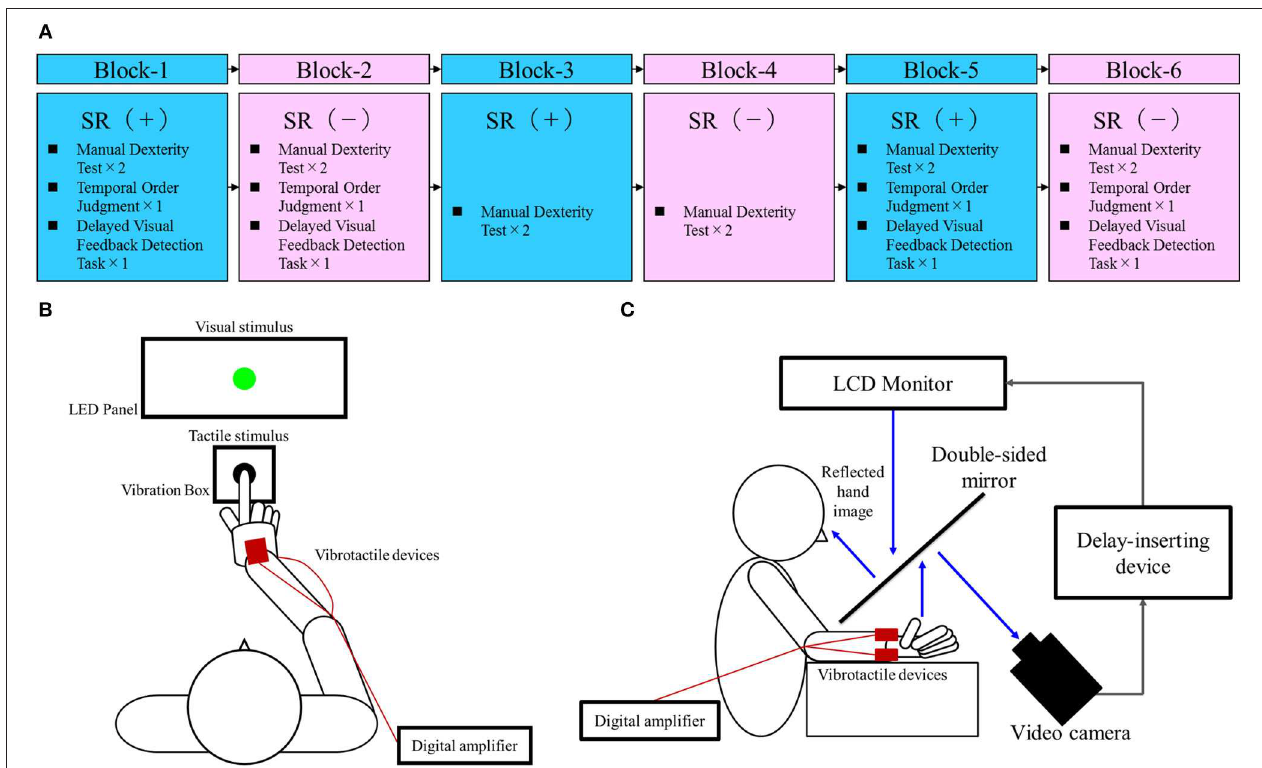
FIGURE 1 | Block design of the experimental protocol and experimental tasks. (A) Block design of the experimental protocol. Blue squares, stochastic resonance (SR) on-condition ( + ); Pink squares, SR off-condition (–). (B) Temporal order judgment task. A visuo-tactile temporal order judgment (TOJ) device (Keio method, UT-0021, Medical Try System, Tokyo, Japan) was used for the present task. This device included an LED panel (UT-0021-2, Medical Try System, Tokyo, Japan) and vibration box (UT-0021-1, Medical Try System, Tokyo, Japan), which provided the visual and tactile stimuli, respectively. The child put the index finger of his right hand in the hole of the vibration box and contacted the vibrotactile stimulator. Therefore, the case could not observe the tactile stimulus. The child was requested to watch the LED panel. The TOJ task device was to set conditions for the synchronized presentation of the visual and tactile stimuli, and the presentation of the visual stimulus at 50 and 100ms earlier than the tactile stimulus (or vice versa). In addition, the setup included a blackout curtain so that the child would not be able to see outside the experimental chamber. (C) Delayed visual feedback detection task. The child’s right hand was placed under a two-way mirror so that he was unable to see his right hand directly. The image of the hand, which was reflected in the two-sided mirror, was filmed with a video camera (FDR-AXP35, Sony, Tokyo, Japan). The movie of the photographed hand was further reflected from an installed monitor (LMD-A240, Sony, Tokyo, Japan) onto the two-sided mirror via a video delay-inserting device (EDS-3306, FOR-A YEM ELETEX, Tokyo, Japan). Thus, the child observed the delayed image of his right hand reflected in the mirror at the position where his right hand would be. In addition, the setup included a blackout curtain so that the child would not be able to see outside the experimental chamber. The intrinsic delay of the visual feedback in this experimental setting was 33.7ms as measured by a time lag check device (EDD-5200, FOR-A YEM ELETEX, Tokyo,